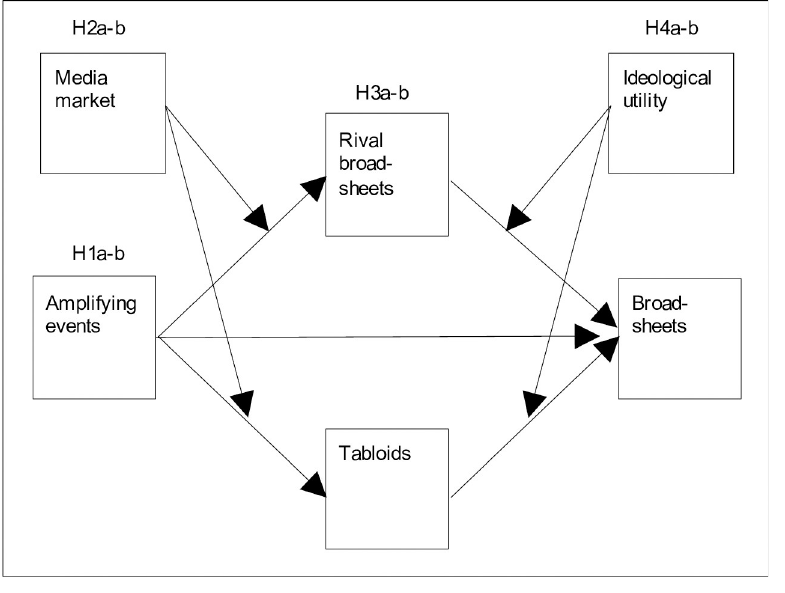
Fig 1. Theoretical